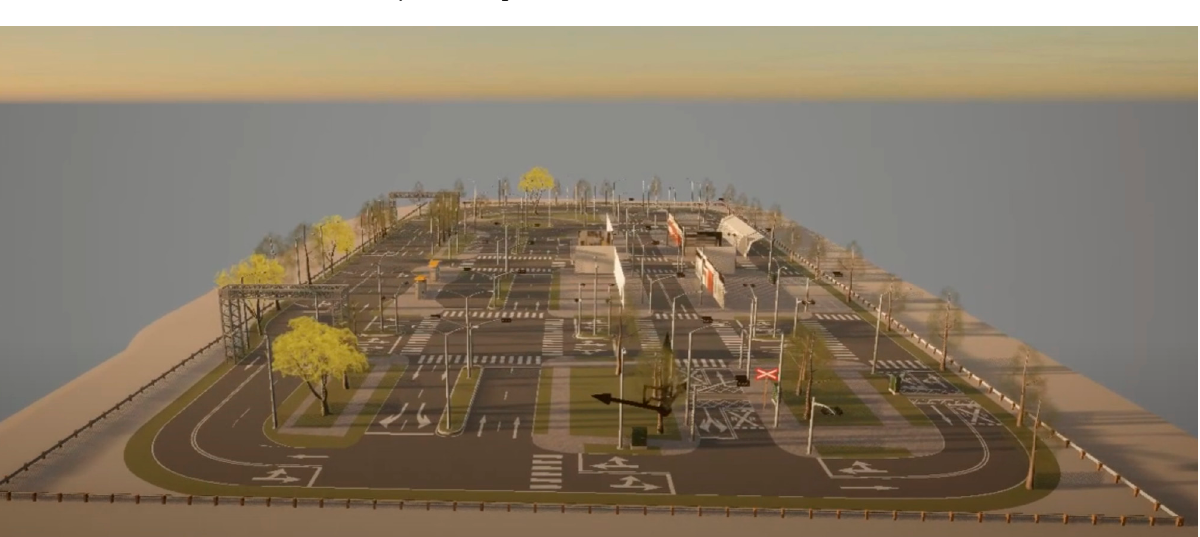
Table 5. Results achieved from modeling roads in OpenDRIVE format.